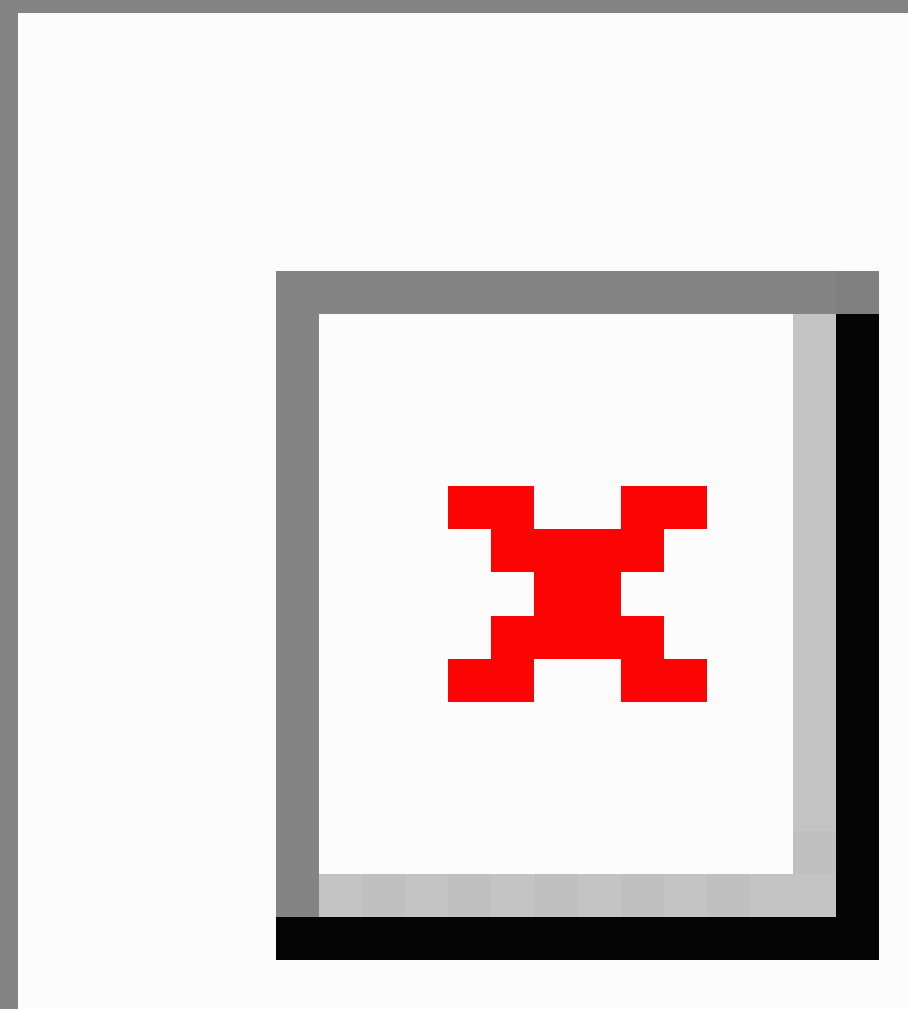
Figure 2. Overview of the study procedure and